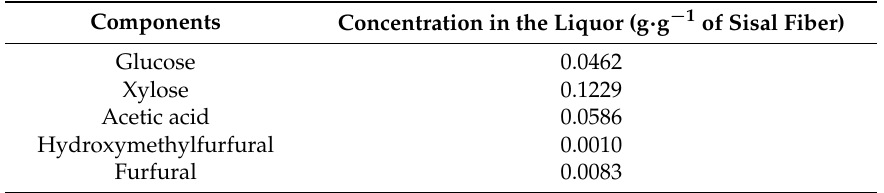
Table 4. Composition of the sisal fiber